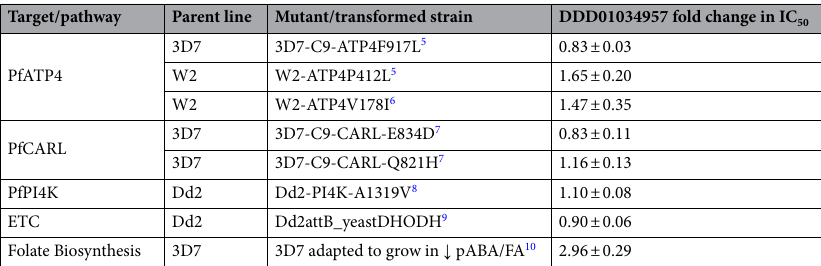
Table 1. DDD01034957 is efficacious against common resistant parasite lines. DDD01034957 was tested against a range of published drug resistant parasite strains and their parental lines in asexual growth assays with parasite lactate dehydrogenase activity (pLDH) as a readout for parasite growth. Presented data is the mean fold change in IC 50 of three to nine independent replicates ±